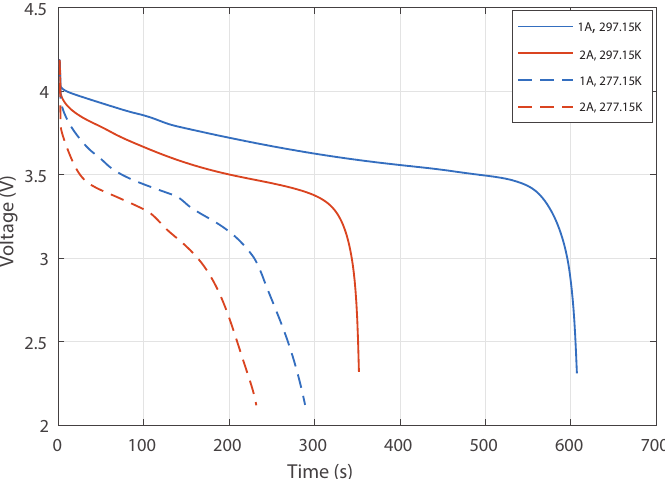
Figure 2. Discharge curves for different current, (i.e., 1.0 A and 2.0 A) and for different temperatures (297.15 K and 277.15